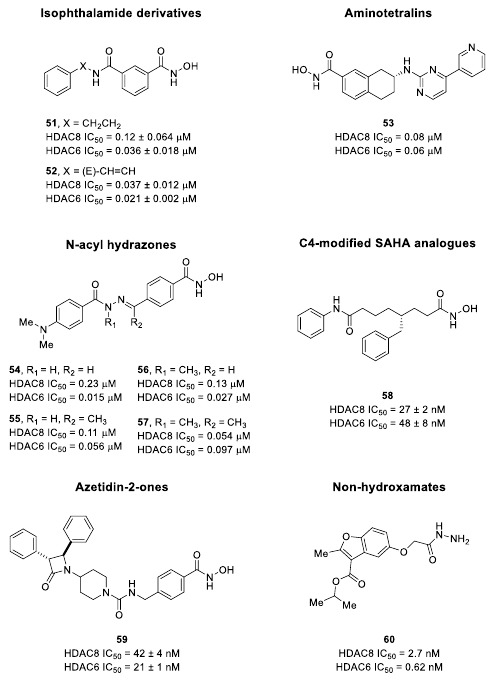
Figure 10. Representation of reported dual HDAC6/8is [21,36,160,161,164,169]. During the development of selective HDAC8is by in silico screening and in vitro biological evaluation, compound 60 (Figure 10, HDAC6 IC 50 = 0.62 nM; HDAC8 IC 50 = 2.7 nM) emerged as a potent non-hydroxamic HDAC6/8 dual inhibitor. This compound was discovered by computational studies that initially focused on the selection of a predictive pharmacophore hypothesis for selective HDAC8 inhibition, starting from the structurally diverse 32 known selective HDAC8is. The most predictive hypothesis was then used to build a 3D QSAR model. Subsequently, virtual screening of the Phase database, in silico ADMET optimization of the fitting hits, and docking studies with HDAC8 and other HDAC isoforms followed, yielding five non-hydroxamate hit compounds, which were then synthesized and exclusively tested in vitro on HDAC isoforms 6 and 8 [169]. 6.2.2. Selective HDAC6/8/10 Multi-Target Inhibitors In 2018, Kolbinger et al. disclosed the structure of TH34 ( 61 , Figure 11), a novel HDAC6/8/10 inhibitor capable of selectively inhibiting the three isoforms in low-micromolar concentrations (HDAC6 IC 50 = 4.6 μM; HDAC8 IC 50 = 1.9 μM; HDAC10 IC 50 = 7.7 μM), as a potential therapeutic agent for the treatment of high -grade neuro- blastoma. It was shown that a combination of TH34 and all- trans retinoic acid synergis- tically inhibited colony growth of neuroblastoma cell lines.